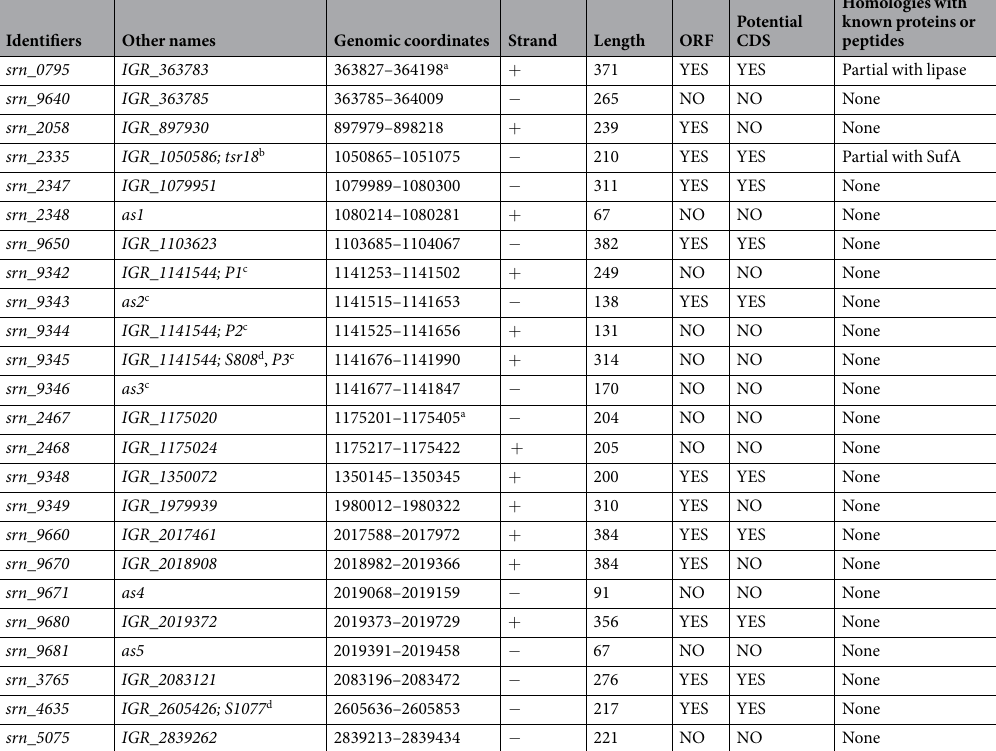
Table 5. Coordinates of 24 novel transcripts determined by RACE-mapping in Staphylococcus aureus Newman and their assigned Srn identifiers. a not mapped by RACE; b described by Carroll et al . 21 ; c described in Fig. 3, Table 3, and Table 4; d described by Mader et al . 15 . ORF of 30 codons or more were identified using ORFinder. Potential CDS were searched using BLAST within the non-redundant database. Homologies with known proteins were searched using Uniprot database. Homologies were described as partial when the coverage and length of the amino acid sequence did not exceed 60% of the homologous protein